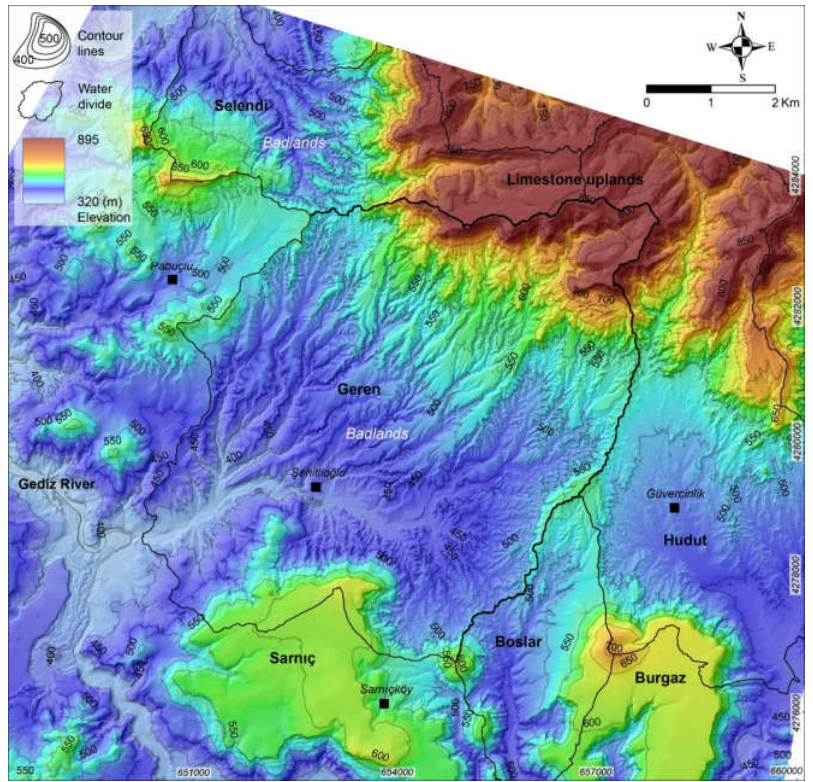
Figure 3. Topographic map of the badlands and the surrounding area showing erosive surface features, deepened gullies and water divides. Plateau and catchment names are indicated as well as village names.